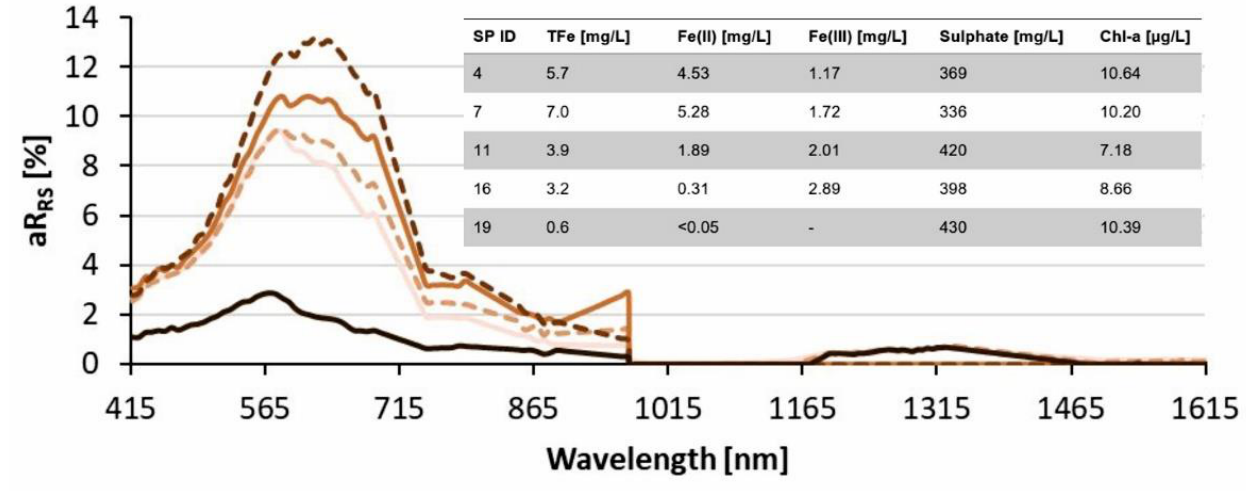
Figure 6. Representation of five airborne hyperspectral spectra in the wavelength range of 420 to 1500 nm with different TFe concentrations at the sampling points. The jump at 1000 nm resulted from the inaccuracies of the internal calibration of the two hyperspectral data sets of HySpex VNIR and HySpex SWIR to the one final hyperspectral data set (400–2500 nm). These overlapped in the wavelength range of approximately 1000 nm and could occur with differences of up to 4%. The table contains the in situ measurements of the five measuring points (see also Table